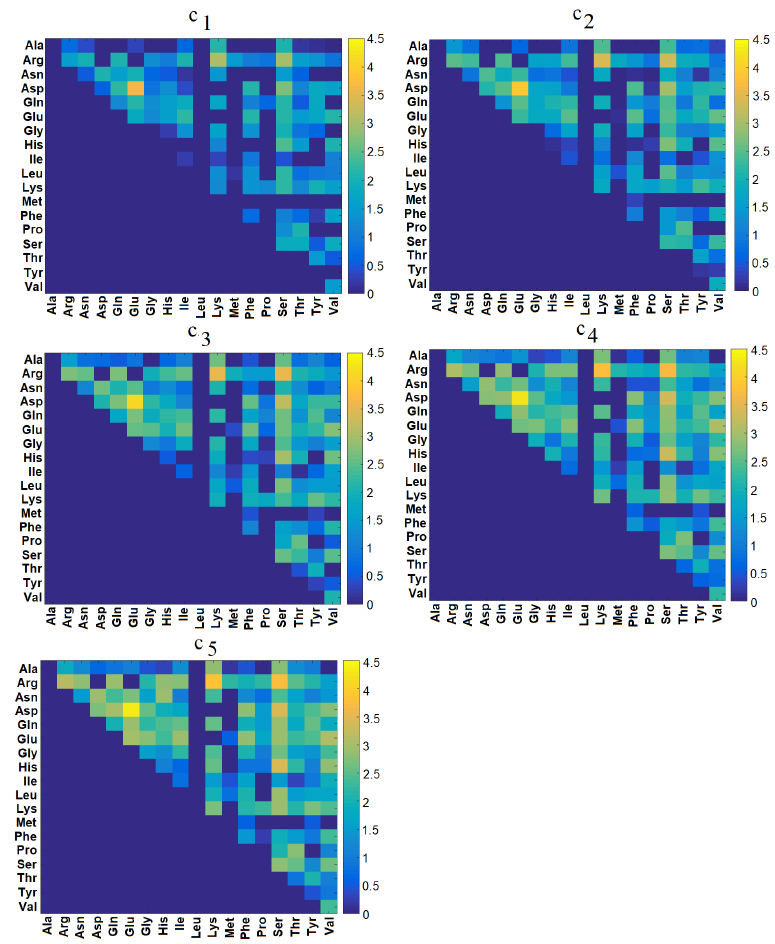
Figure 5. Maps of interaction energies (kJ/mol) between each pair of AA in mucin. A large difference between the number of inter- and intra-molecular interactions for both HP and HBO can be seen (see Figures 6 and 7).